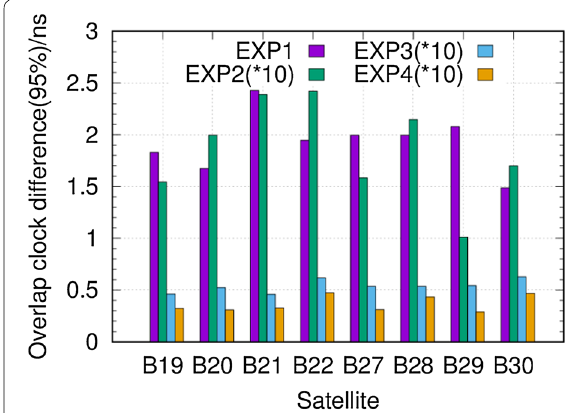
Fig. 3 Overlap clock differences (95%) in the 4 experiments for each satellite. The values of EXP2, EXP3 and EXP4 have a tenfold magnification to illustrate the differences